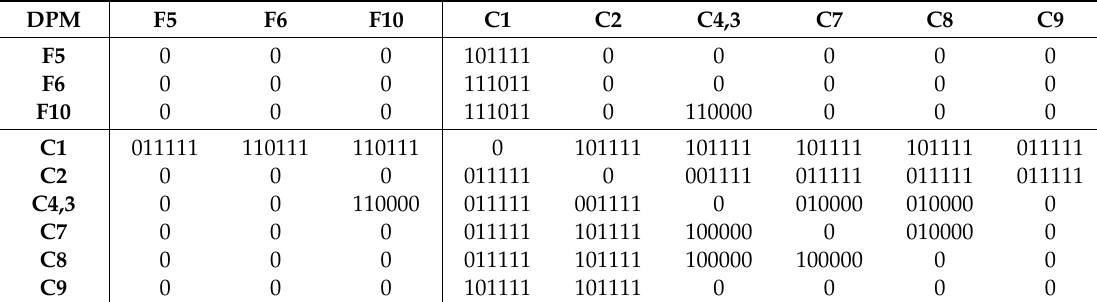
Table 2. Disassembly precedence